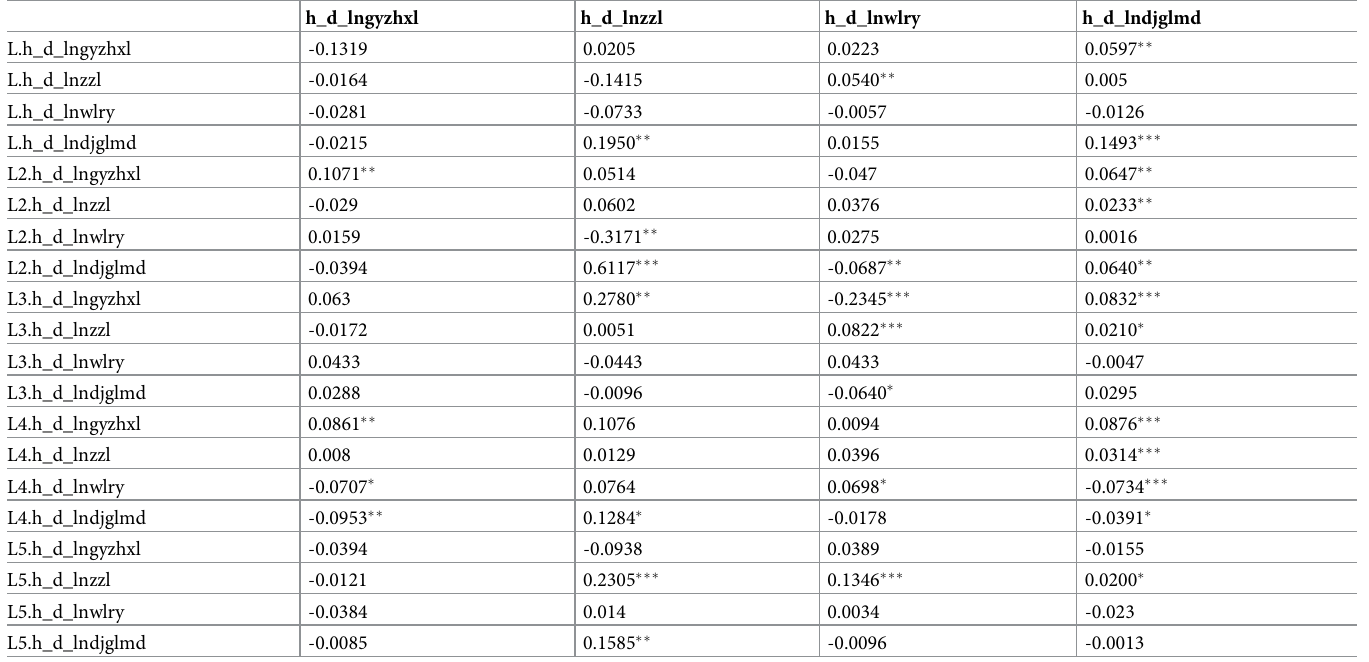
Table 8. GMM estimation results of PVAR model for logistics industry and the comprehensive technical efficiency of manufacturing